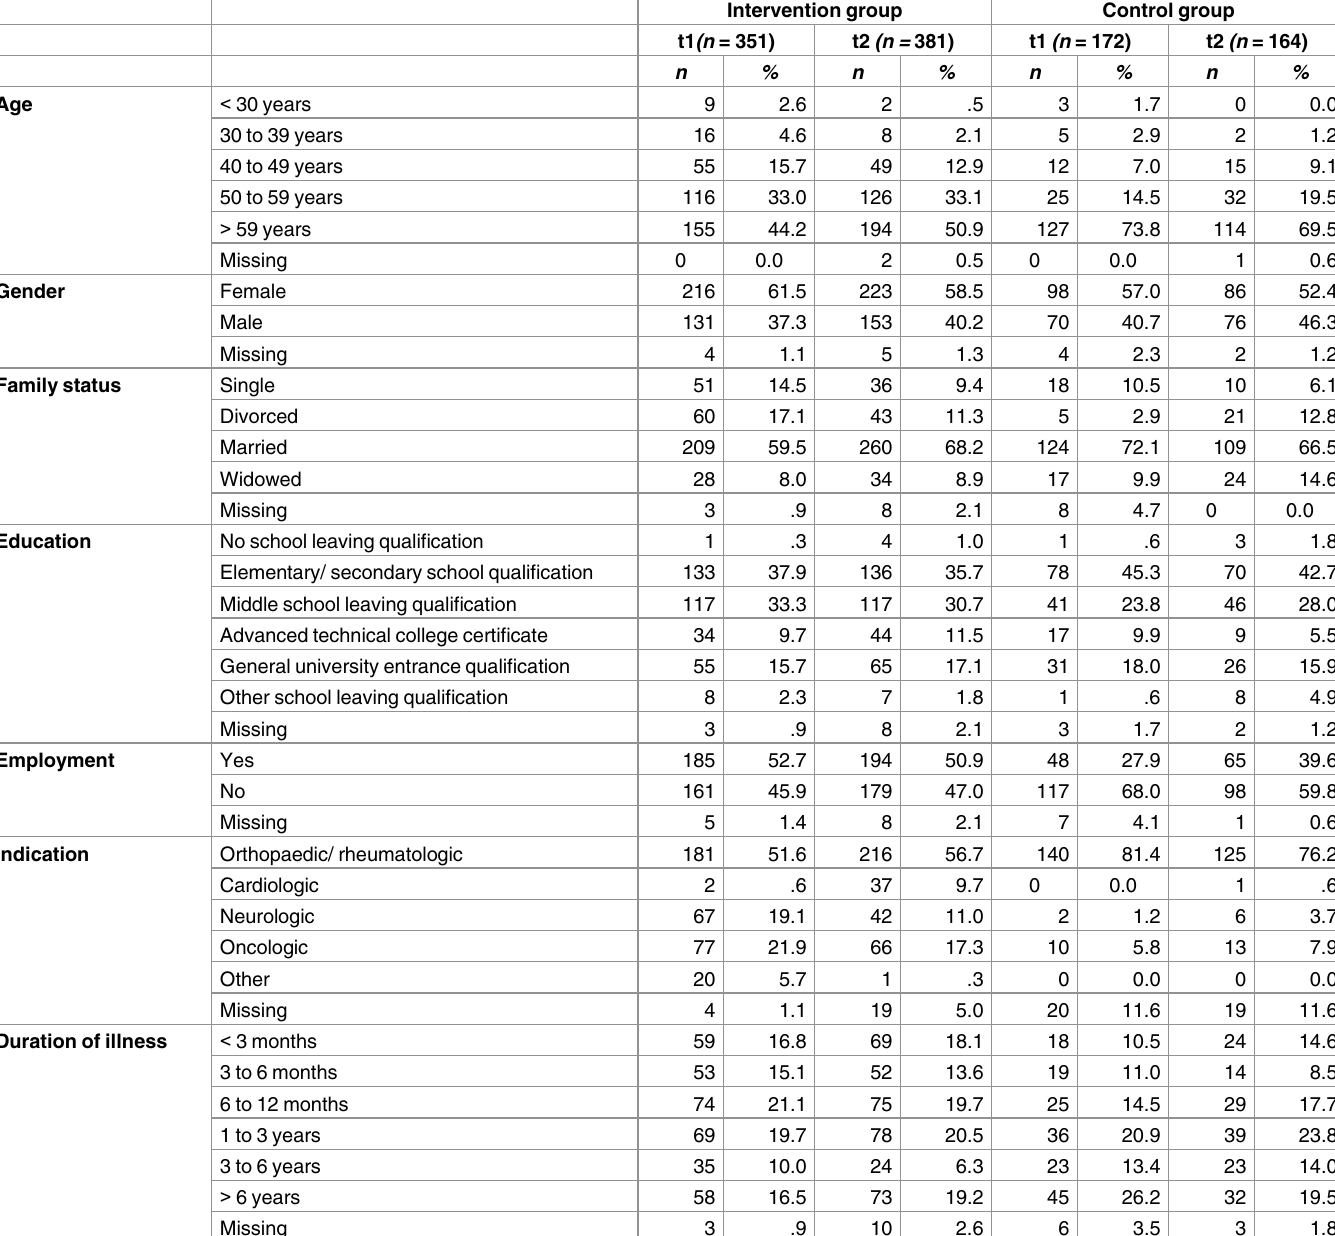
Table 3. Patient sample for t1 and